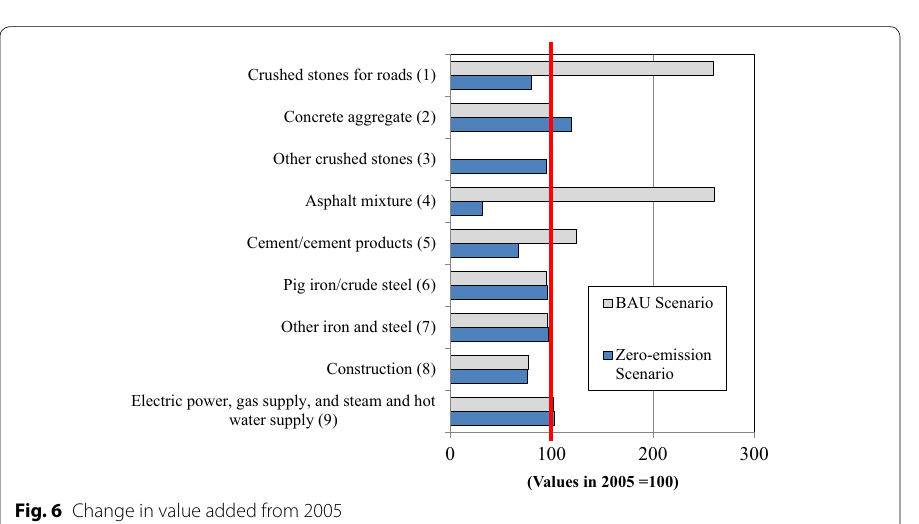
Fig. 6 Change in value added from